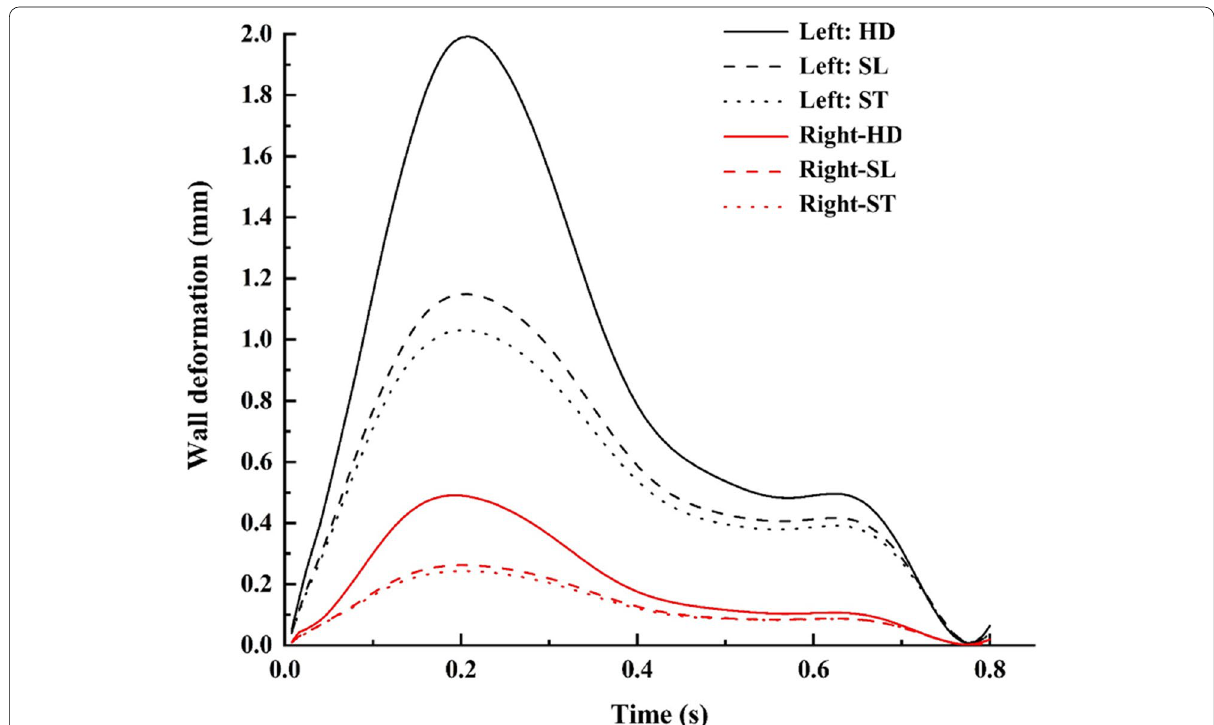
Fig. 13 Wall deformation comparison for various